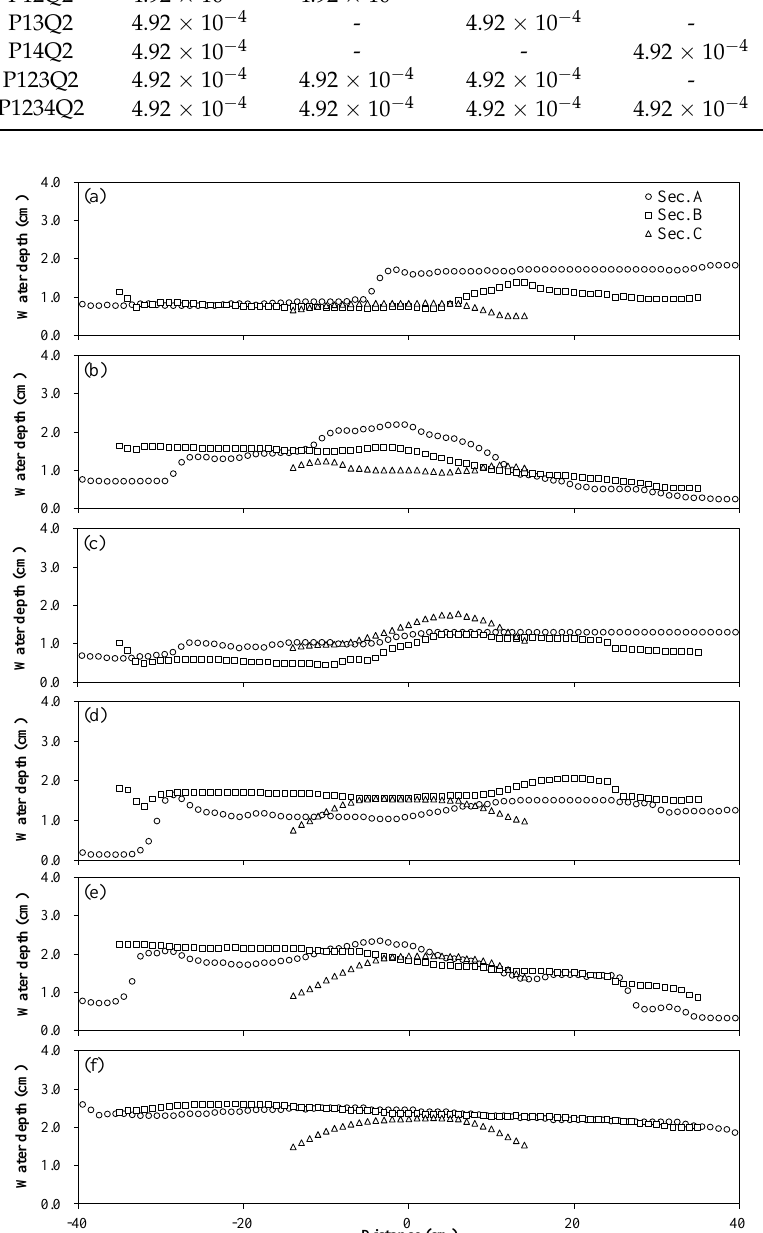
Figure 9. Comparison of the inundation depth by changing the inflow position: ( a ) Case P1Q1; ( b ) Case P12Q1; ( c ) Case P13Q1; ( d ) Case P14Q1; ( e ) Case P123Q1; ( f ) Case P1234Q1.